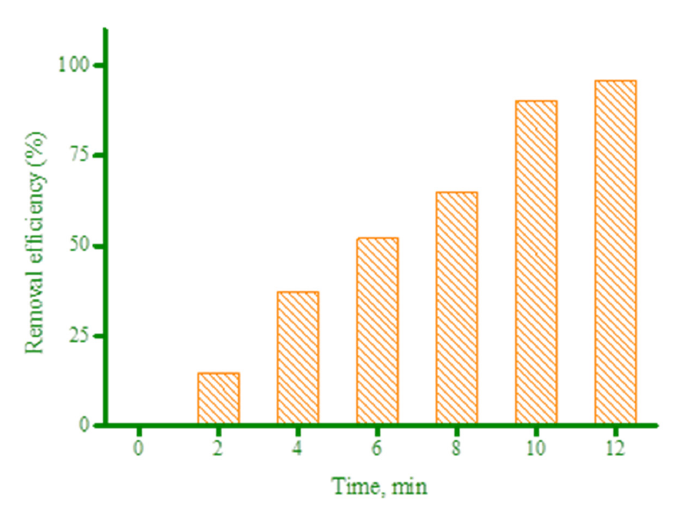
Figure 15. Removal efficiency (%) of AC (10 mg in 100 mL of deionized water) using 40 mg of the fullerene CNT at different contact times.